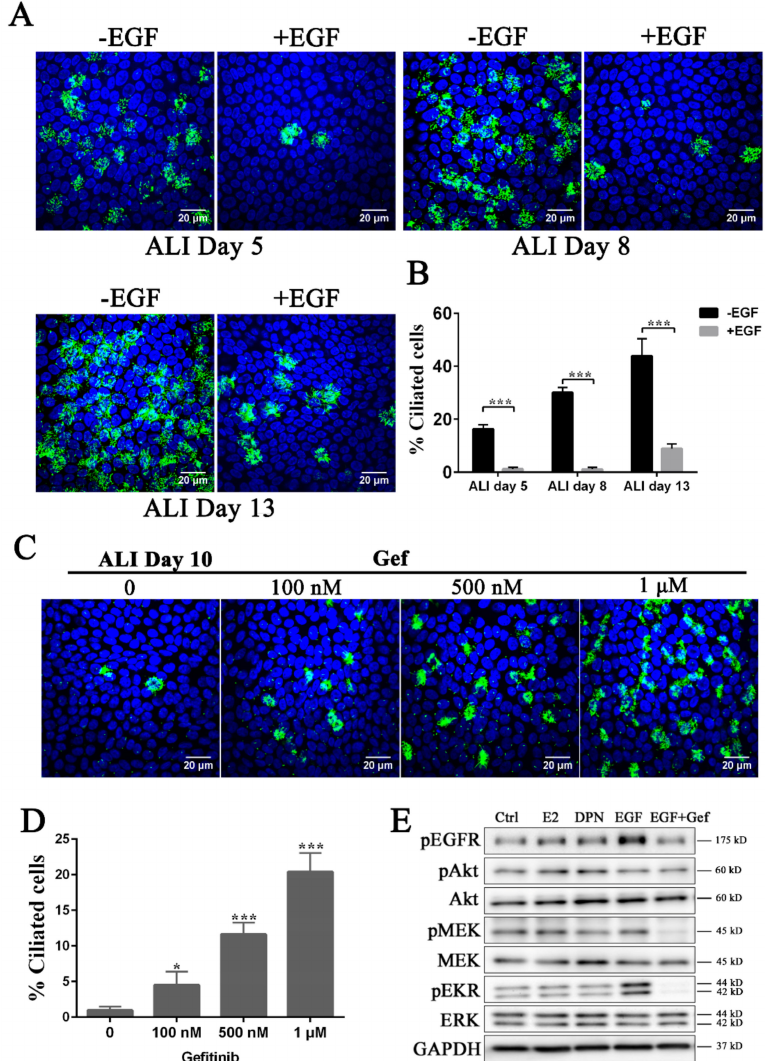
Figure 3. EGFR-MEK-ERK pathway negatively regulates ciliogenesis. ( A ) FTECs were cultured in basal medium with or without 10 ng / mL EGF, followed by the addition of 2 ng / mL E2 under ALI culture. Cells were stained for ac-tubulin (green) and nuclei (blue). Scale bars: 20 µ m. ( B ) The numbers of ac-tubulin-positive cells in A were quantified (ANOVA test, n = 5). ( C ) FTECs were cultured with di ff erent concentrations of gefitinib with 10 ng / mL EGF. Cells on ALI day 10 were stained for ac-tubulin (green) and nuclei (blue). Scale bars: 20 µ m. ( D ) The numbers of ac-tubulin-positive cells were quantified (ANOVA test, n = 5). ( E ) Western blot analysis of EGF-pathway related proteins in FTECs. FTECs P1 were thawed and passaged onto 12-well plate after confluency. In the last panel, cells were pre-treated with gefitinib for 30 min and then all FTECs were treated with other reagents for 15 min. Significance level: * p < 0.05, ** p < 0.01, and *** p <